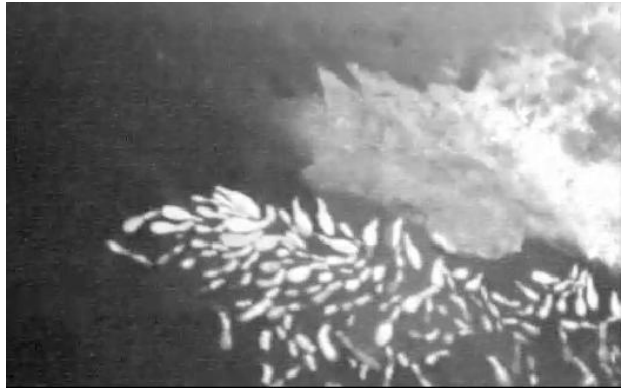
Figure 9: Input image before